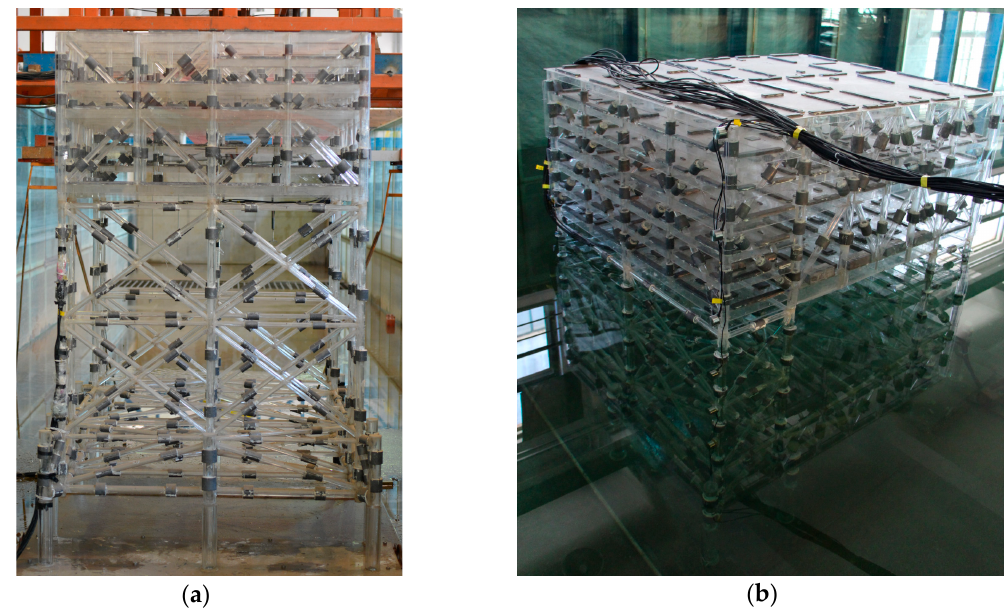
Figure 3. The electrical platform model in the wave flume. ( a ) In air; ( b ) In water.